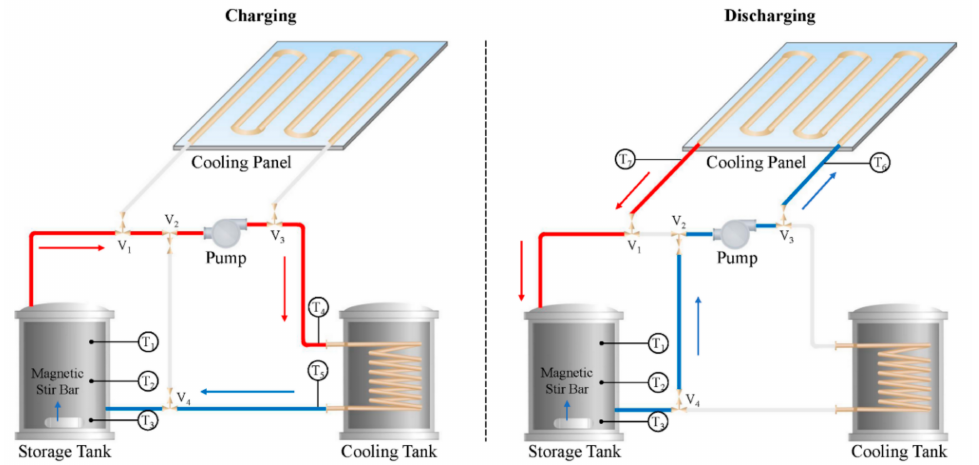
Figure 10. The photograph and geometry of 46 L storage tank (Reproduced with permission from Ref. [118]. Copyright 2015 Elsevier).